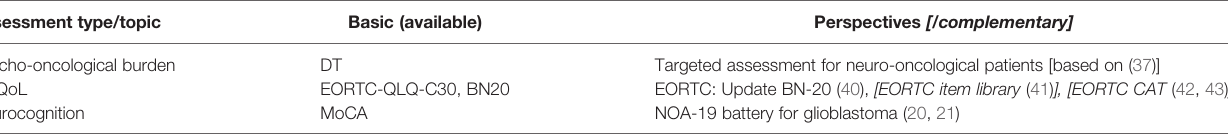
TABLE 4 | Recommendations for a basic, comprehensive assessment for brain tumor